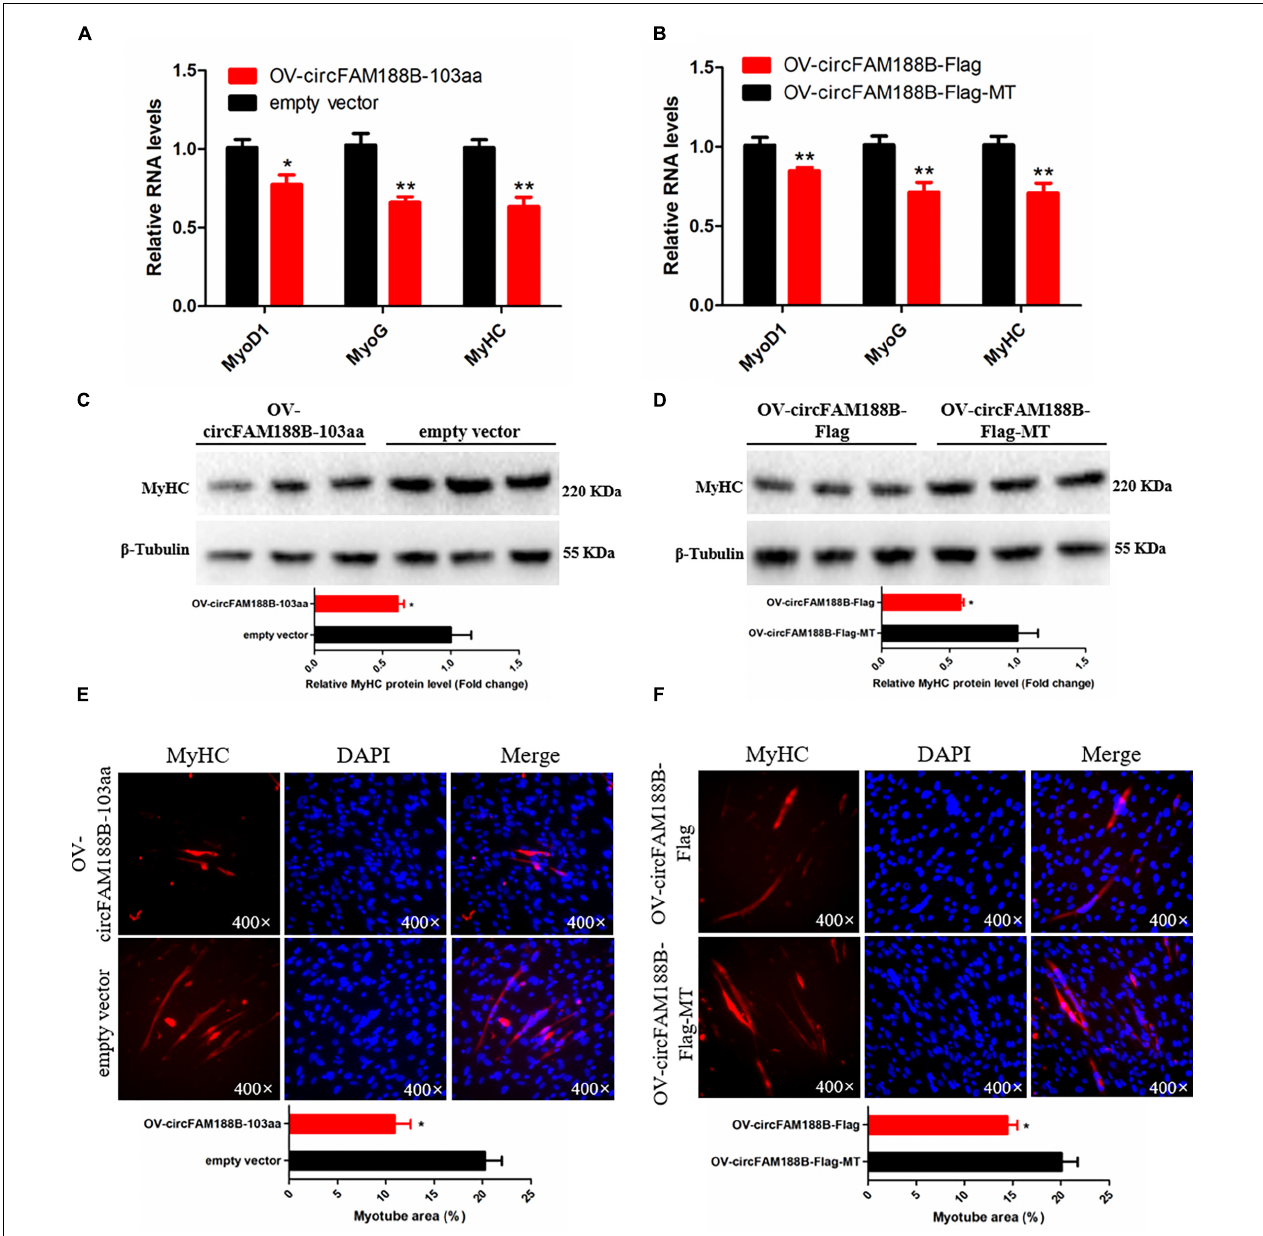
FIGURE 8 | CircFAM188B-103aa inhibits chicken SMSC differentiation. (A,B) The relative RNA level of muscle cell differentiation marker genes in chicken SMSCs following circFAM188B-103aa overexpression. (C,D) The levels of MyHC and β -tubulin proteins in SMSCs following circFAM188B-103aa overexpression (upper panel) . MyHC band intensities were quantified using Image J and normalized against β -tubulin (lower panels) . (E,F) Image of MyHC staining of SMSCs following circFAM188B-103aa overexpression (upper panels) . Relative myotube area (ratio of MyHC fluorescence area to DAPI area) of SMSCs following circFAM188B-103aa overexpression (lower panel) . The results of all groups are shown as mean ± S.E.M., and the data represent three independent assessment methods. Student’s t -test was used to compare expression levels or values among different groups. * P < 0.05; ** P <